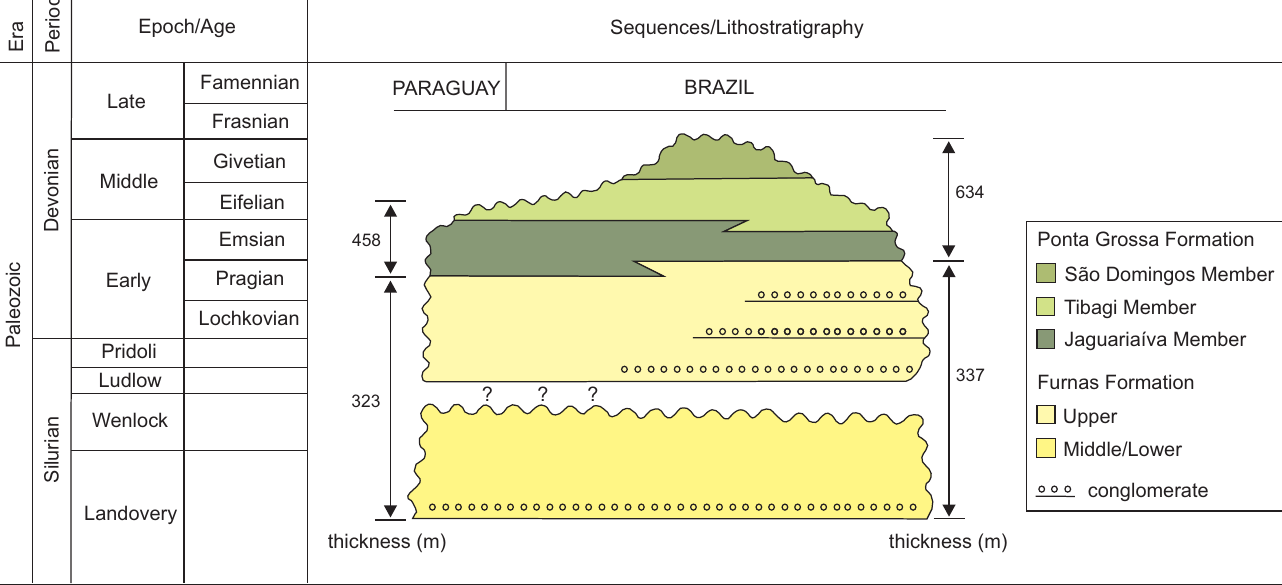
Fig. 2. Stratigraphic chart of the Silurian–Devonian interval in the Paraná Basin (modified from Assine et al. 1994; Sedorko et al . 2017). The exact level in the Jaguariaíva Member at which Clarke’s (1913) specimens of Sphenothallus were found is not